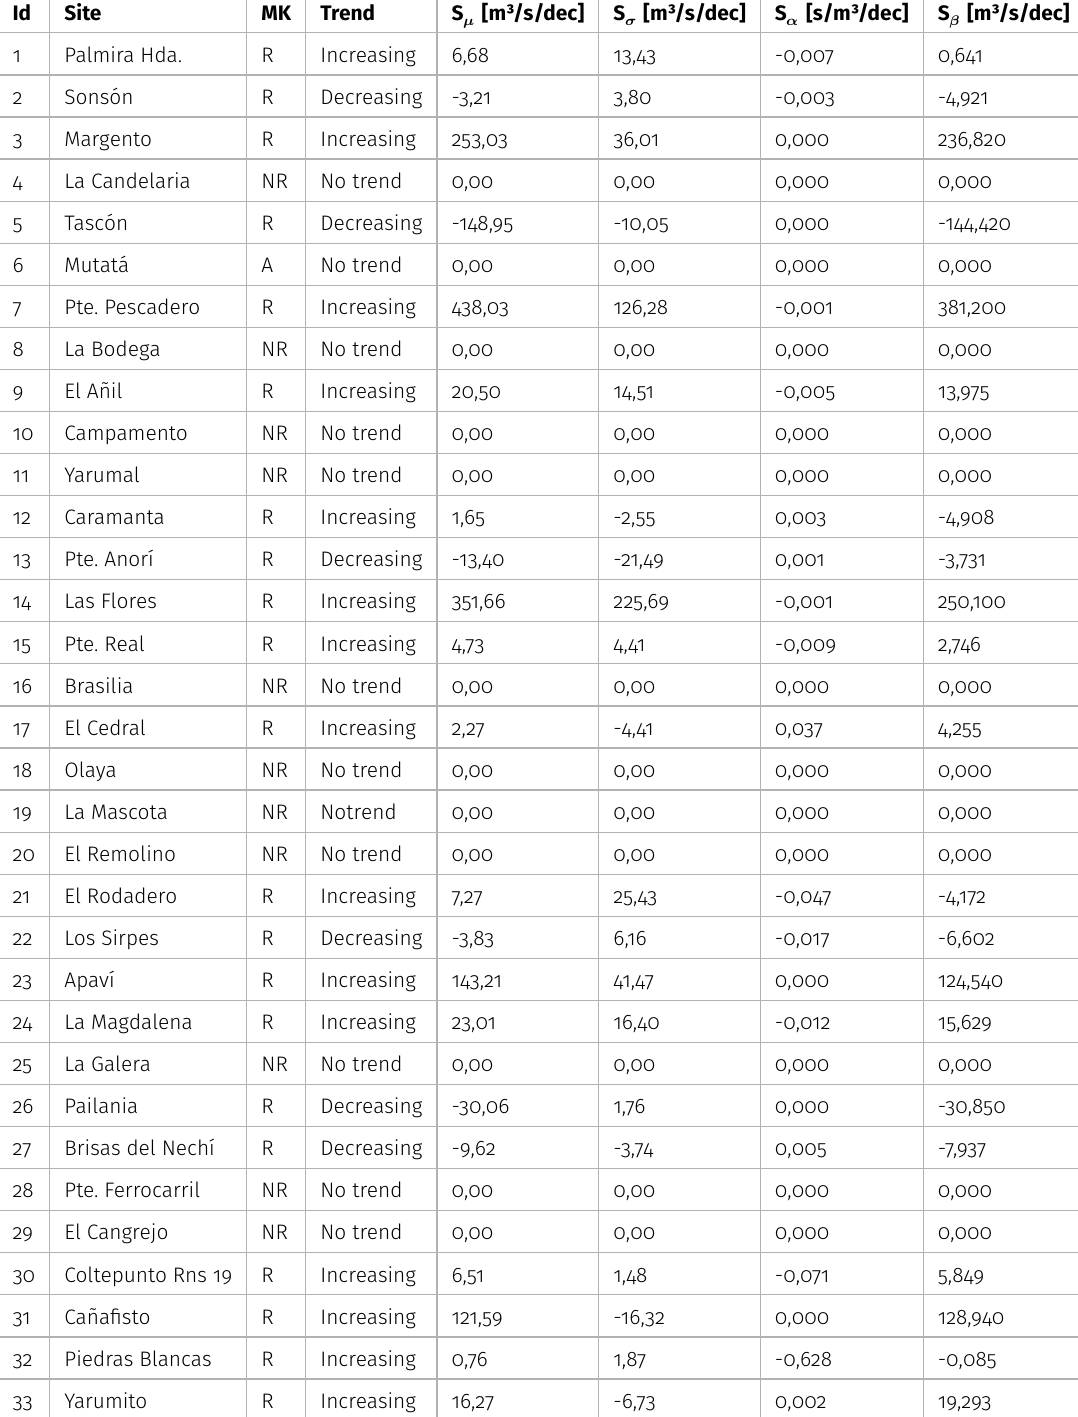
Table II. Long-term trends in the parameters of annual maximum discharge time series in Antioquia. Third column shows the MK test results. R: Ho rejected. NR: Ho not